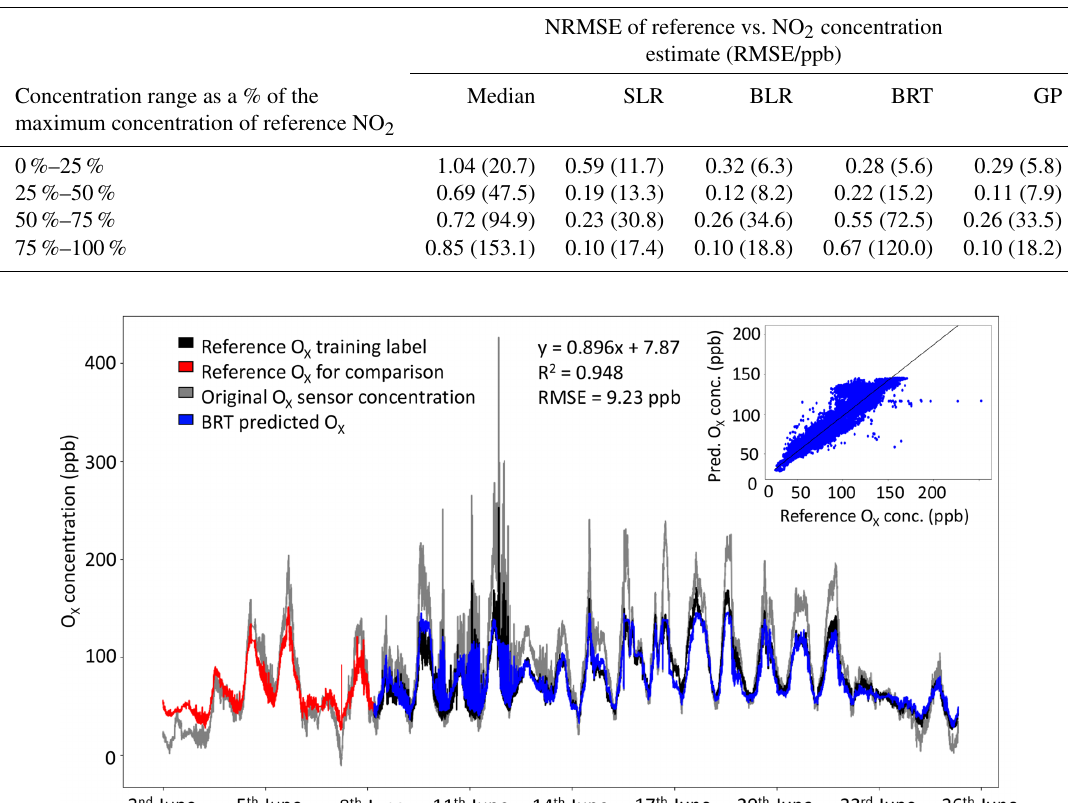
Table 2. The NRMSE and RMSE between the NO 2 reference and sensor datasets at different concentration ranges. For each calibration method used in the paper, the data were binned into 25% of the observed reference concentration. The RMSE and the NRMSE were calculated for each concentration bin and the results for NO 2 and O x are summarized in the table below. The NRMSE was calculated by dividing the RMSE between the reference observations and the sensor values by the mean reference concentration for the respective bin.